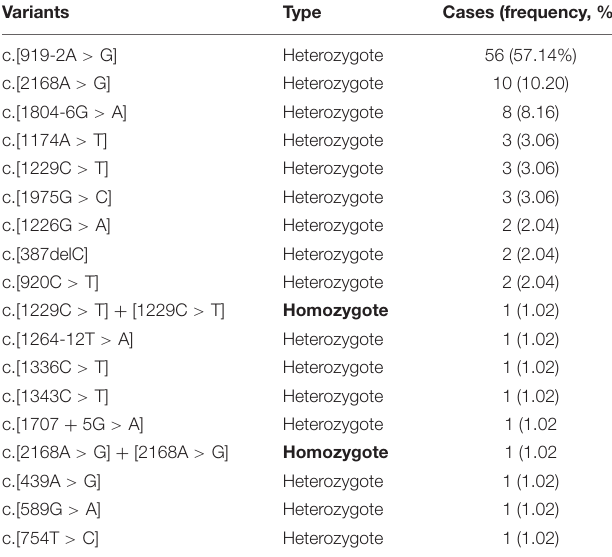
The bold means the pathogenic deafness-associated